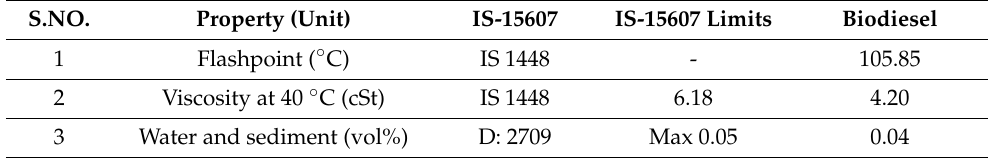
Table 8. Physicochemical properties of